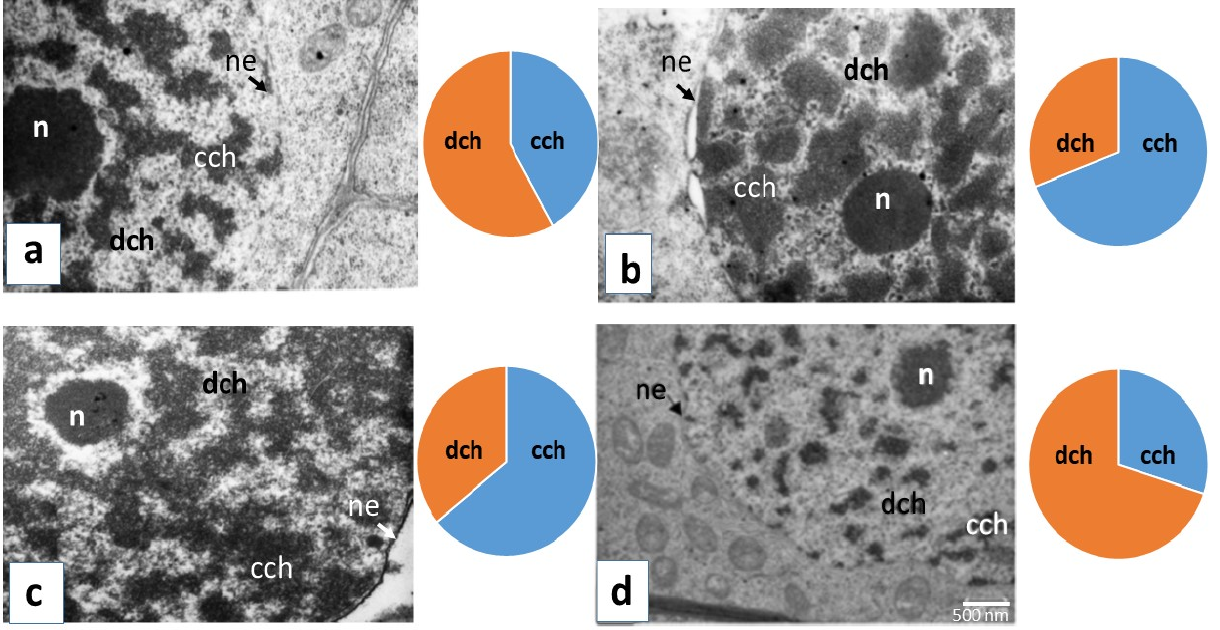
Figure 3. Nucleus ultrastructure in MZ of the main root cells of Nicotiana tabacum during germina- tion in water ( a ). In the presence of AEDL ( b ), in the presence of 150 mM NaCl ( c ), and in the joint presence of NaCl and AEDL ( d ) after 28 days of germination. Symbol: n—nucleolus,